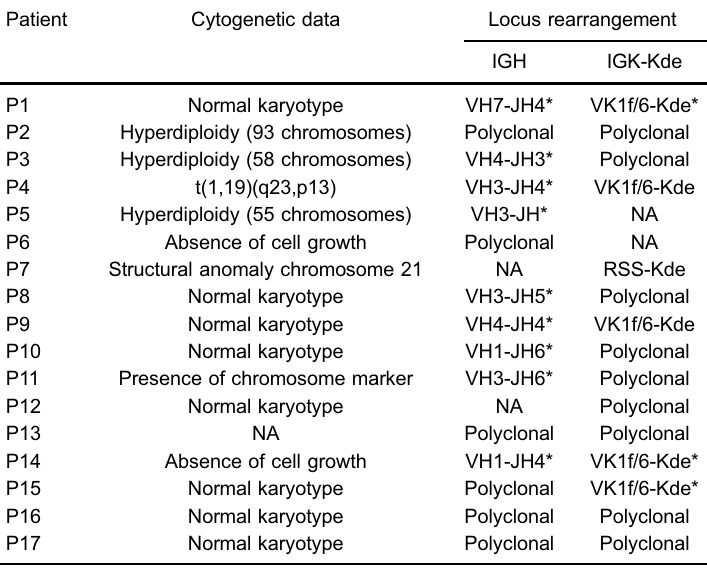
Table 1. Molecular characteristics of 17 B lineage acute lymphoblastic leukemia patients at